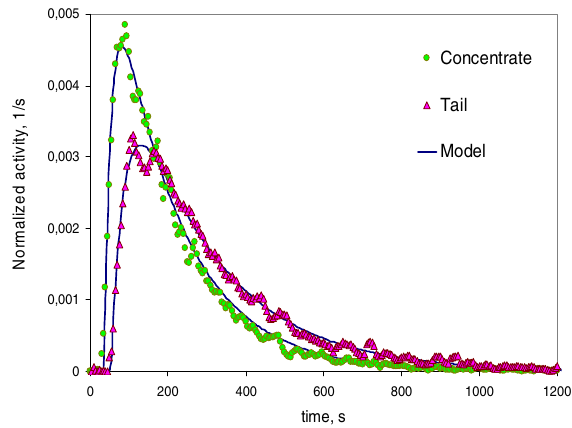
Figure 10. Residence time distribution of floatable mineral measured in the concentrate and tailings output